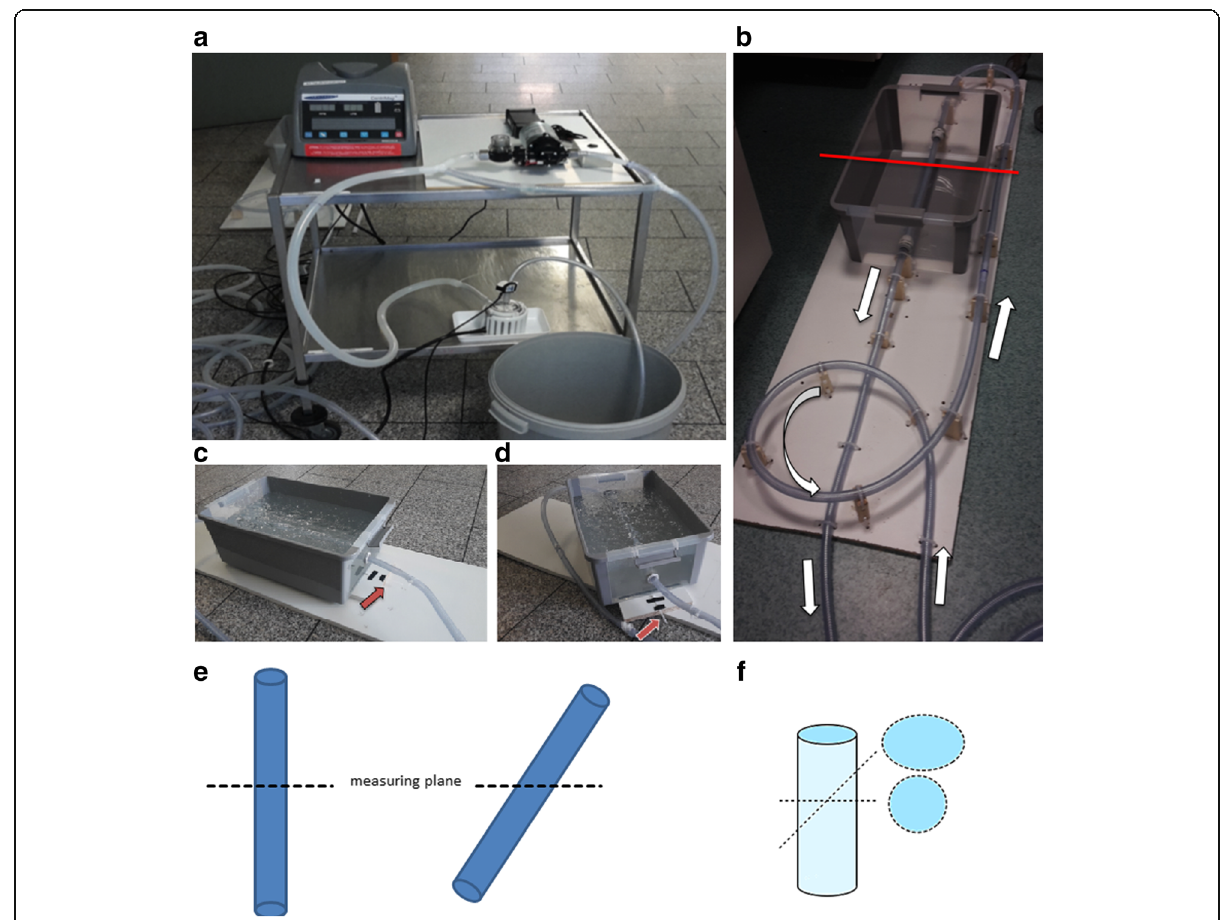
Fig. 1 a , b Overview of the blood pump with control panel and inflow and outflow tubes. c , d The plastic tub filled with carbopol gel containing the tissue tube could be rotated. The red arrow indicates a goniometer. c Orthogonal orientation. d 45° rotation. e Schematic showing 2D flow measurements with the phantom vessel positioned along the z -direction of the MRI scanner (0°) and with an altered angle (45°). f